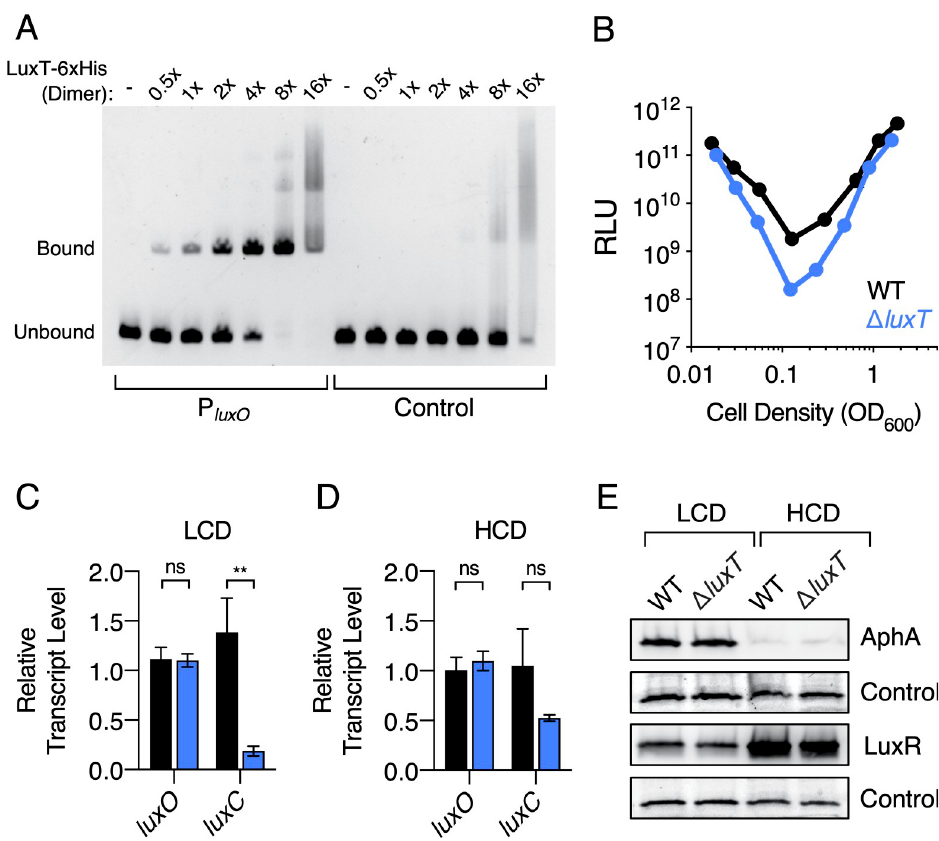
Fig 2. LuxT binds upstream of luxO , but it does not repress luxO . (A) EMSAs showing binding of LuxT-6xHis to 95 bp DNA fragments consisting of the luxO promoter (left) or control ( E . coli lacZ ) DNA (right). Reaction mixtures contained 20 nM DNA probe and the indicated relative concentrations of the LuxT-6xHis dimer:- = no protein, 1x = 20 nM, 16x = 320 nM. (B) Density-dependent bioluminescence emission from WT (black) or Δ luxT (blue) V . harveyi . Relative light units (RLU) are counts/min mL -1 per OD 600 . Error bars represent standard deviations of the means of n = 3 biological replicates. Standard deviations that are smaller than the symbols are not shown. (C) qRT-PCR of luxO and luxC at LCD (OD 600 = 0.05) of WT (black) and Δ luxT (blue) V . harveyi . Error bars represent standard deviations of the means of n = 3 biological replicates. Unpaired two-tailed t tests with Welch’s correction were performed comparing WT to Δ luxT . p -values: ns � 0.05, �� < 0.01. (D) As in C at HCD (OD 600 = 1). (E) Western blots of AphA-3xFLAG (top) and 3xFLAG-LuxR (3 rd panel from top) in WT and Δ luxT V . harveyi at LCD (OD 600 = 0.01) and HCD (OD 600 = 1). Total proteins were visualized on a stain-free gel before transfer (2 nd and bottom panels), and a dominant band serves as a loading control.